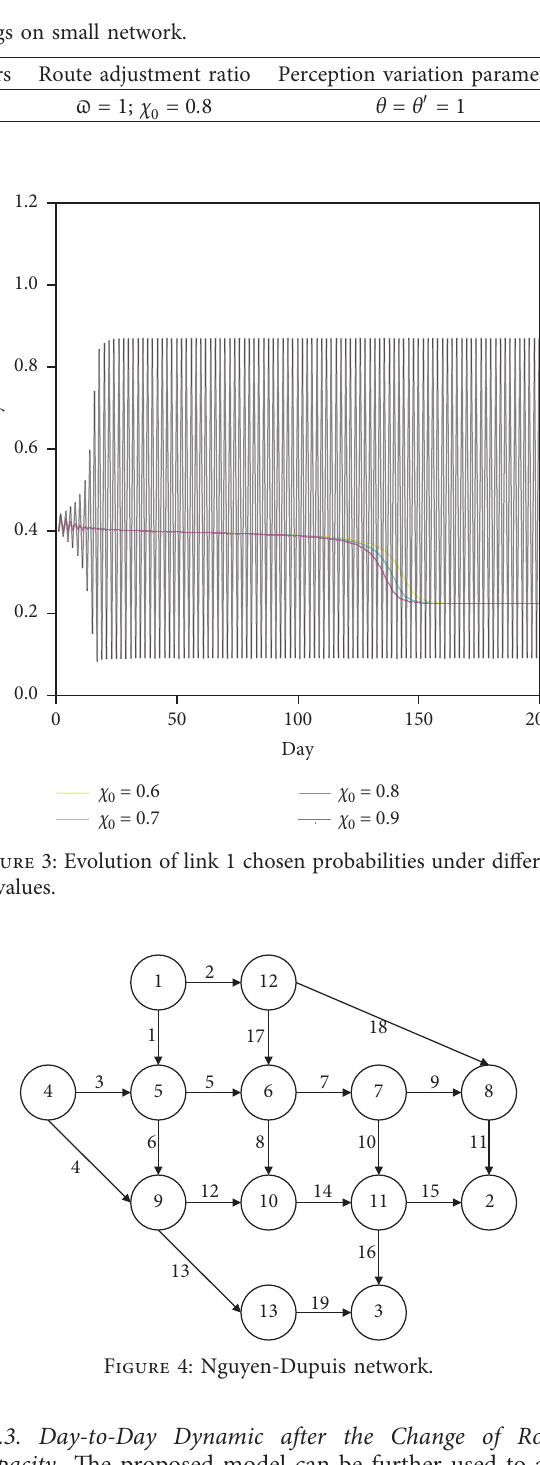
Table 1: Basic numerical settings on small network.